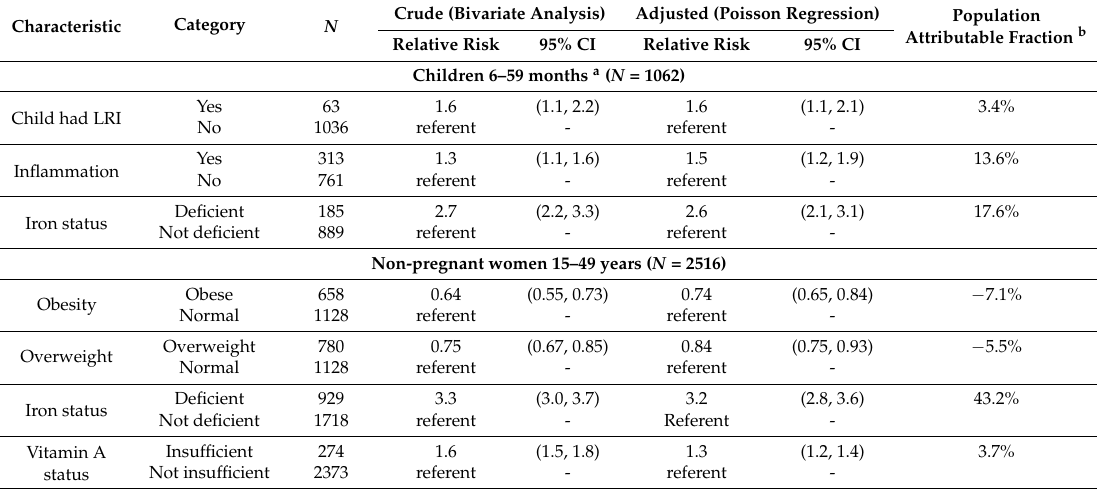
Table 5. Crude and adjusted relative risk of anemia and population attributable fraction in